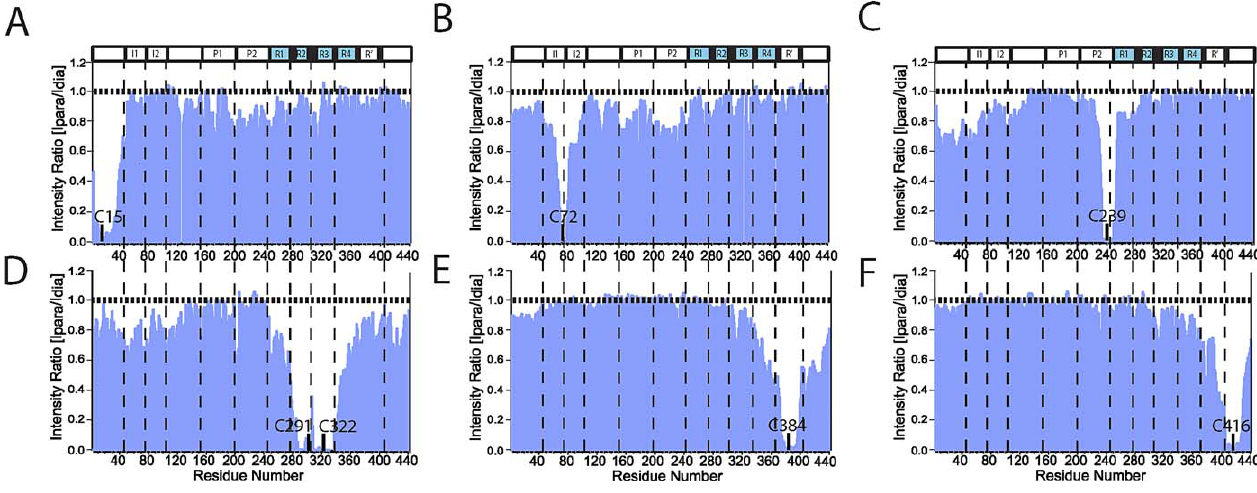
Figure 7. PRE of Amide Protons in Spin-Labelled Tau (A–F) PRE profiles of amide protons in spin-labelled htau40. wt htau40 and five single-cysteine mutants (A15C, A72C, A239C, A384C, and A416C) were labelled with MTSL at residue (A) 15, (B) 72, (C) 239, (D) 291 and 322, (E) 384, and (F) 416. Intensity ratios were averaged over a three-residue window. Decreases in peak intensity ratios that occur far from the site of spin-labelling ( . 10 residues) are indicative of long-range contacts ( , 25 A˚) between the spin-label and distant areas of sequence.